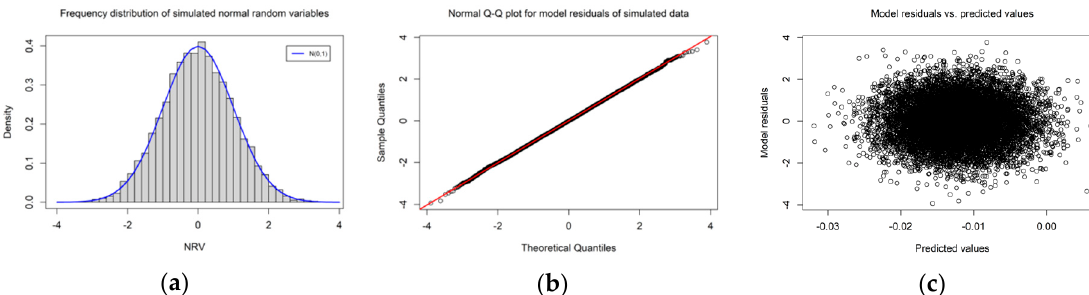
Figure A8. Statistical properties of simulated data and their regression residuals: ( a ) a histogram of simulated data; ( b ) a Q-Q plot of the SAR model residuals; and, ( c ) a scatter plot of residual-predicted values for assessing the homoscedasticity of model residuals.